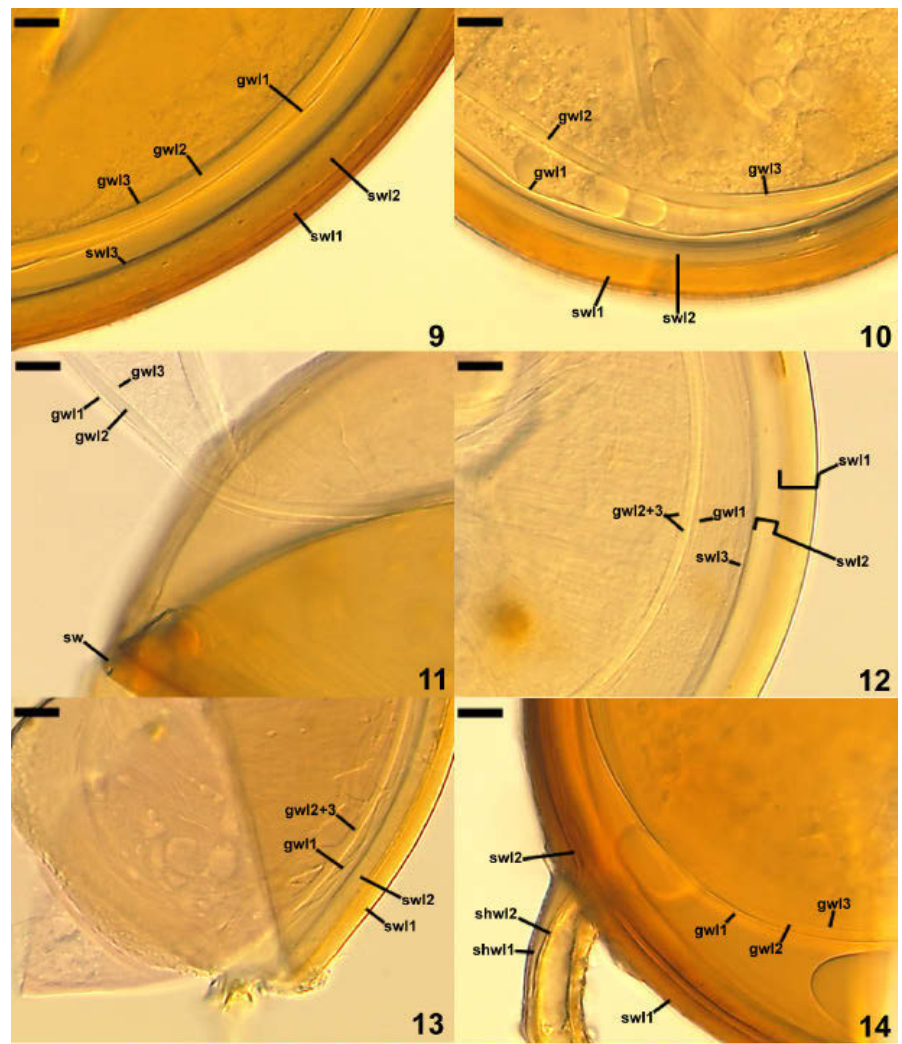
Figs 9-14. Pacispora robiginia . 9-13. Spore wall layers 1-3 (swl1-3) and inner germination wall layers 1-3 (gwl1-3). 14. Spore wall layers 1 and 2 (swl1 and 2) continuous with subtending hyphal wall layers 1 and 2 (shwl1 and 2). Figs 9-12 and 14, spores crushed in PVLG. Fig. 13, spore crushed in PVLG+Melzer’s reagent. Figs 9-14, differential interference contrast. Bars: Figs 9-14=10